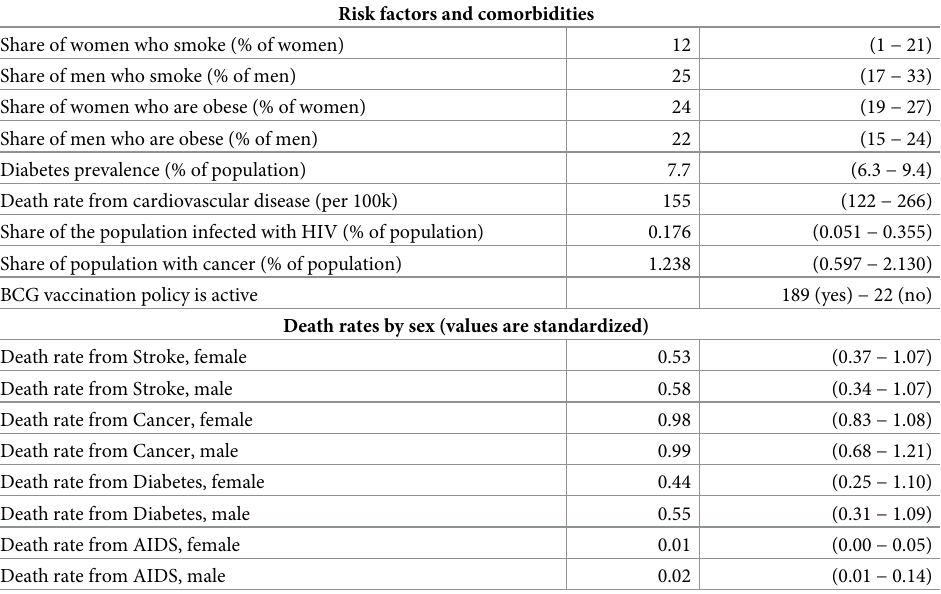
Table 4. Data on risk factors and comorbidities. For each item it is shown the median followed by first and third quartiles (calculated over the 211 countries considered in the study). Risk factors and